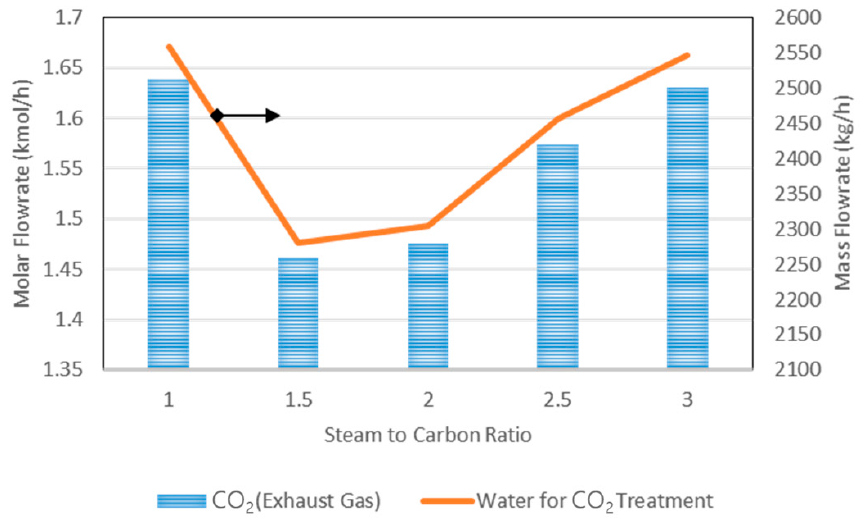
Figure 12. E ff ect of SCR on CO 2 generated and water to solve CO 2. Figure 12. Effect of SCR on CO 2 generated and water to solve CO 2.